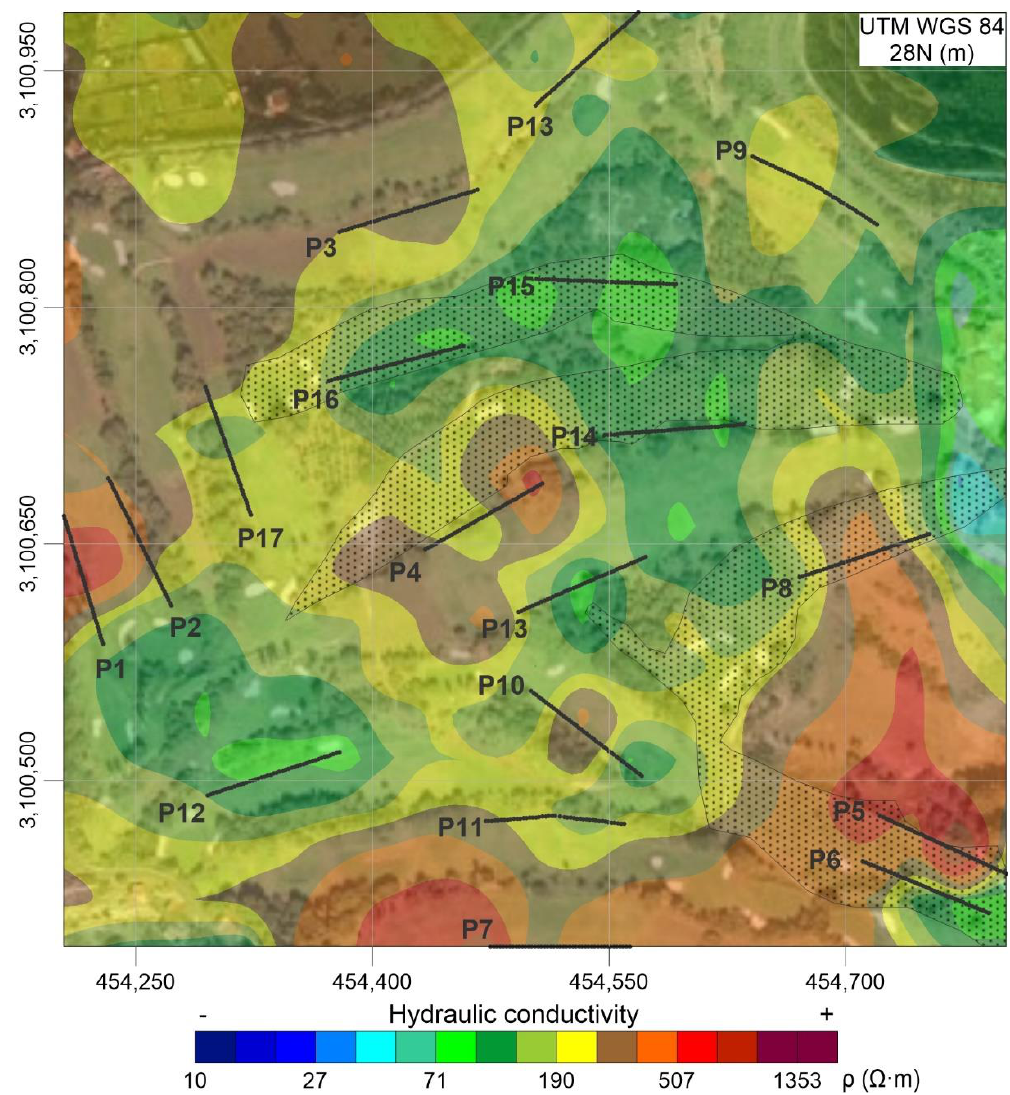
Figure 7. Distribution of the shallow subsurface electrical resistivity interpolated using kriging algorithm [52] from ERT profiles (dark grey lines) acquired over the golf course. Dotted areas represent the location of transported soils.